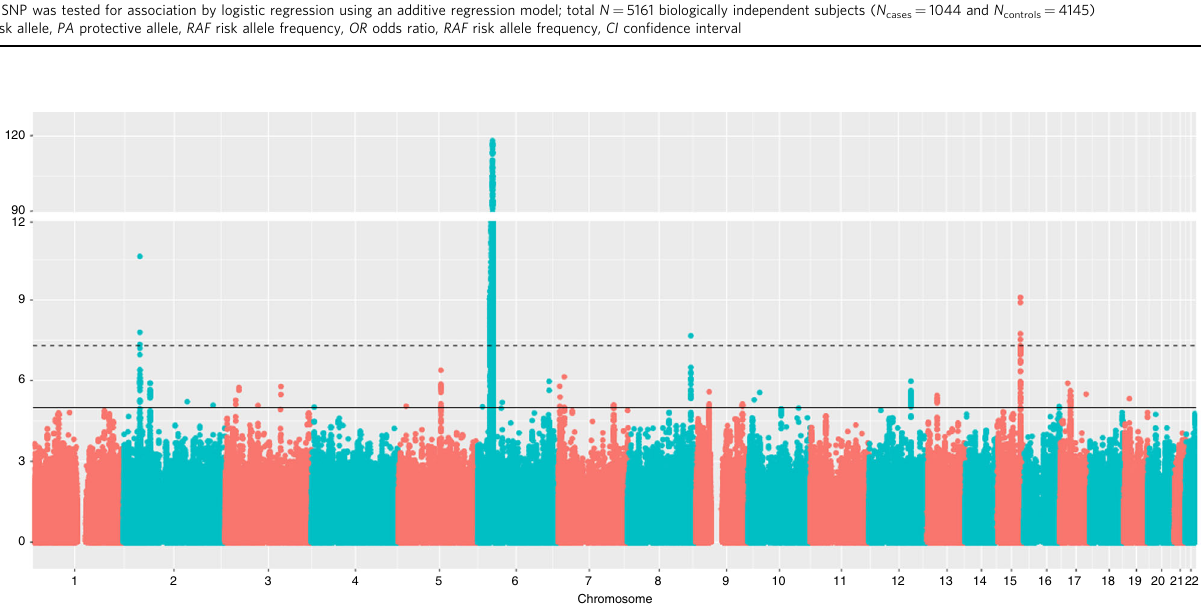
Fig. 2 Manhattan plot showing the P values for the meta-analysis genome-wide association study. Each SNP was tested for association by logistic regression using an additive regression model; the interrupted line indicates the threshold for genome-wide signi fi cance ( P = 5 × 10 − 8 ); the y axis has been collapsed for better illustration of all genomic signals; the continuous line represents the threshold for suggestive signi fi cance ( P = 1 × 10 − 5 ); N = 5161 biologically independent subjects ( N cases = 1044 and N controls =